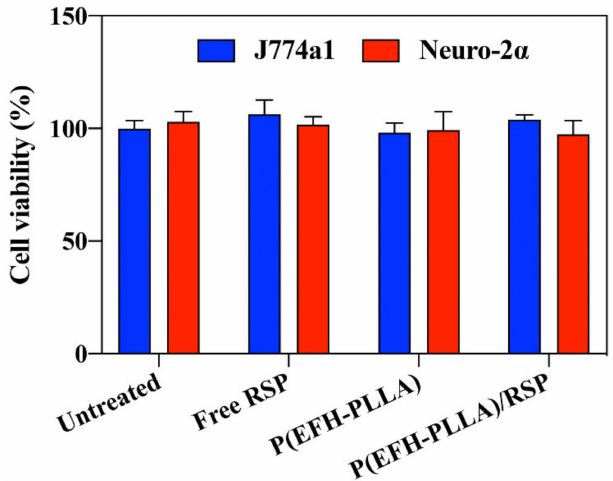
Figure 4. XTT cell viability assay on murine J774A.1 and Neuro-2 α cells after 48 h.